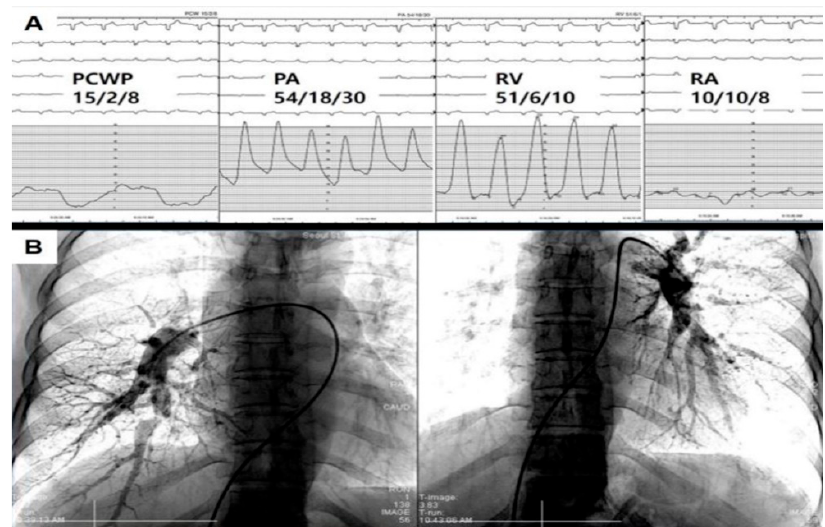
Figure 9. The final diagnosis can be made via RHC ( A ) and DSA ( B ). Abbreviations: PCWP, pulmo ‐ nary capillary wedge